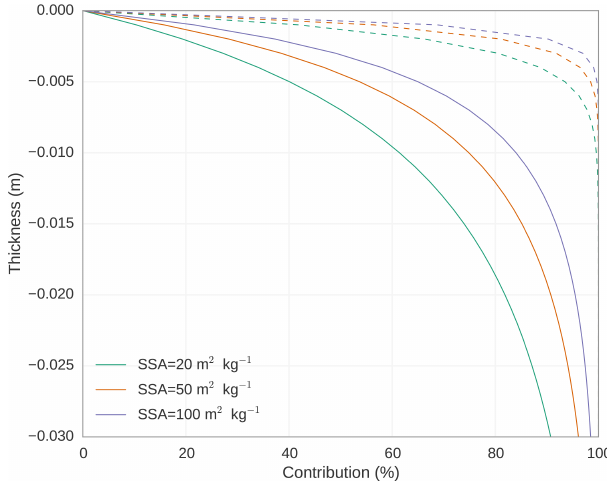
Figure 1. Contribution of the uppermost layer of a semi-infinite snowpack to the albedo averaged over the range 700–1050nm (plain line) and at 1310nm (dash line) as a function of the layer